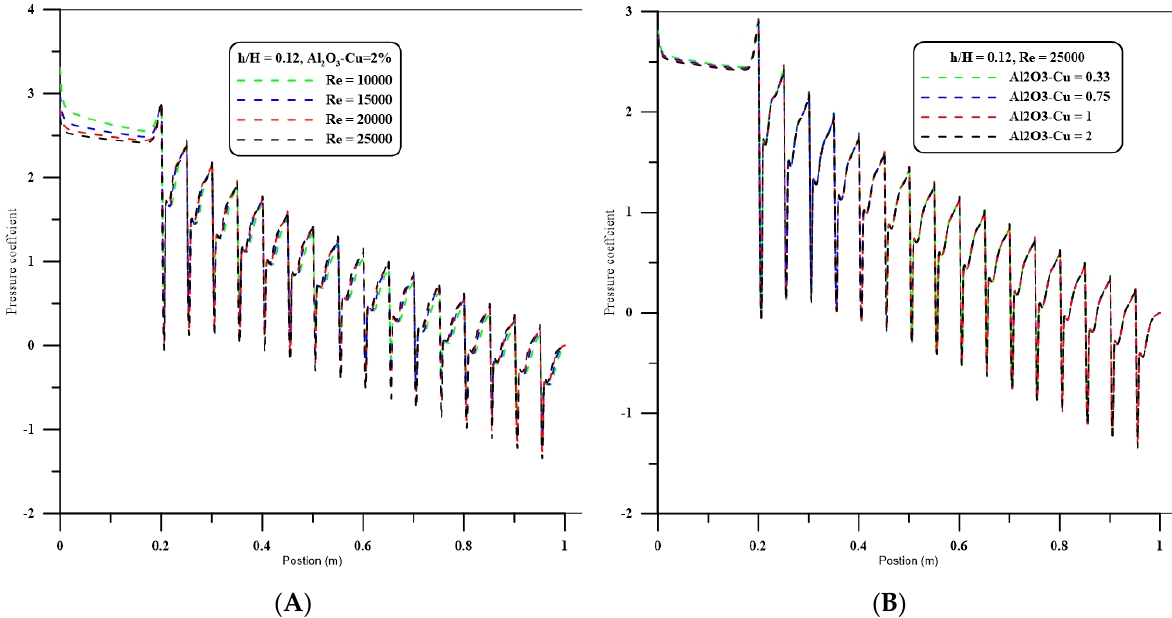
Figure 6. ( A ) Effect of Reynolds number on pressure coefficient for %2 hybrid nanofluids of Al 2 O 3 - CuO at h/H = 0.12 and P/W = 10. ( B ) Effect of volume fraction of hybrid nanofluids of Al 2 O 3 -CuO for Re = 25,000 at h/H = 0.12 and P/W = 10.